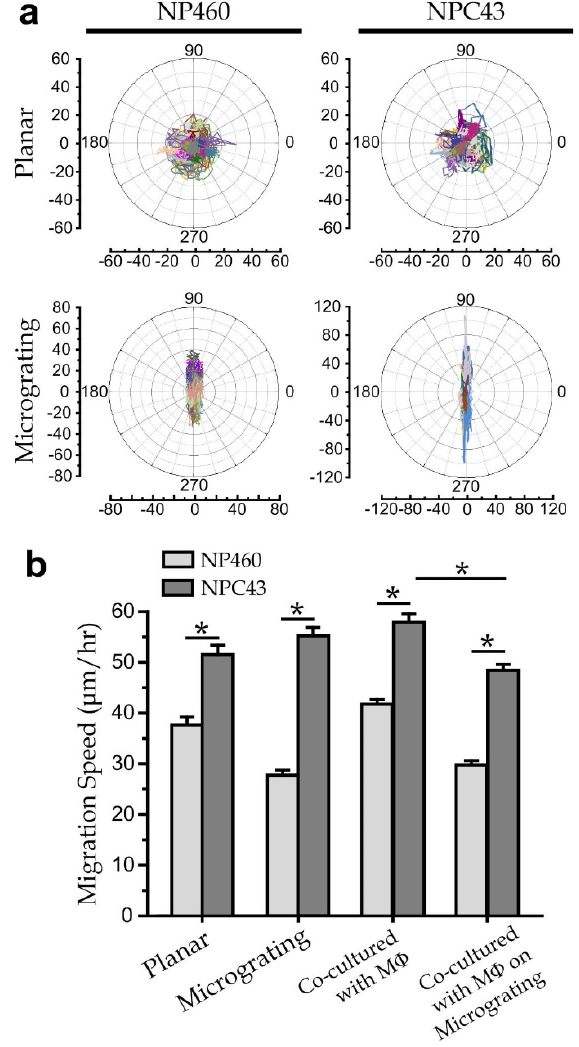
Figure 5. ( a ) Migration trajectories of single NP460 and NPC43 cells on flat/grating substrates. ( b ) Migration speed of single NP460, single NPC43 and those co-cultured with THP-1 derived macrophages on platforms with/without grating. n > 35 for all cases. Error bars represent the standard errors. Asterisk represents a p -value of